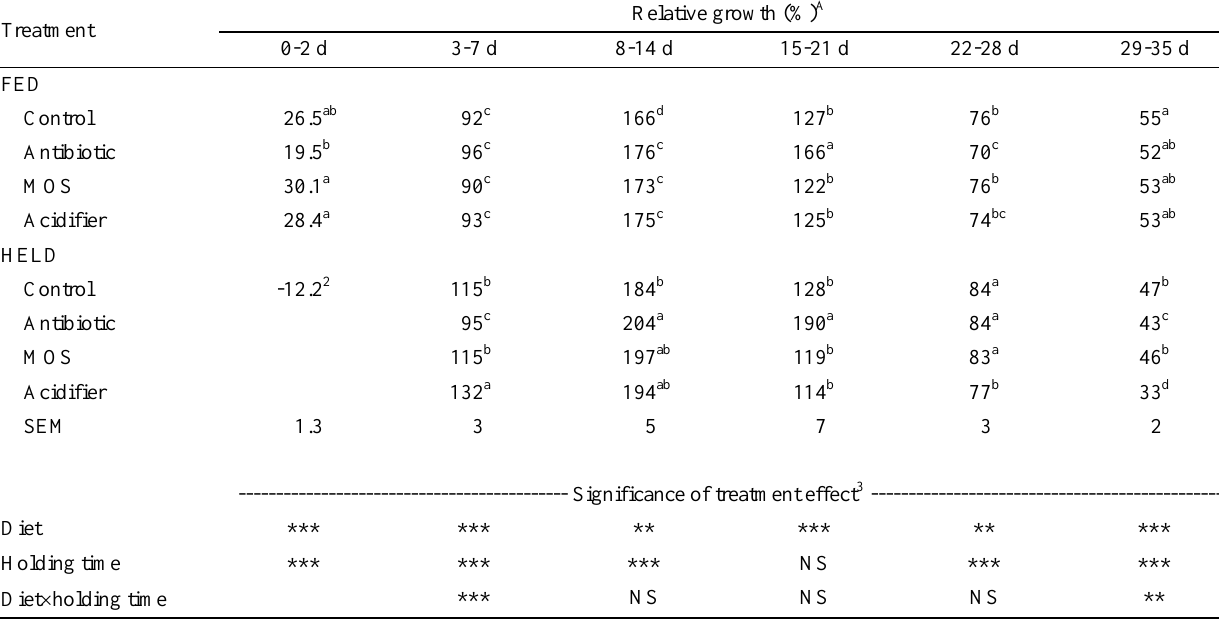
Table 3. Effects of post hatch holding time and dietary supplements on relative growth rate of chicks at d 3, 7, 14, 21, 28 and 35 1